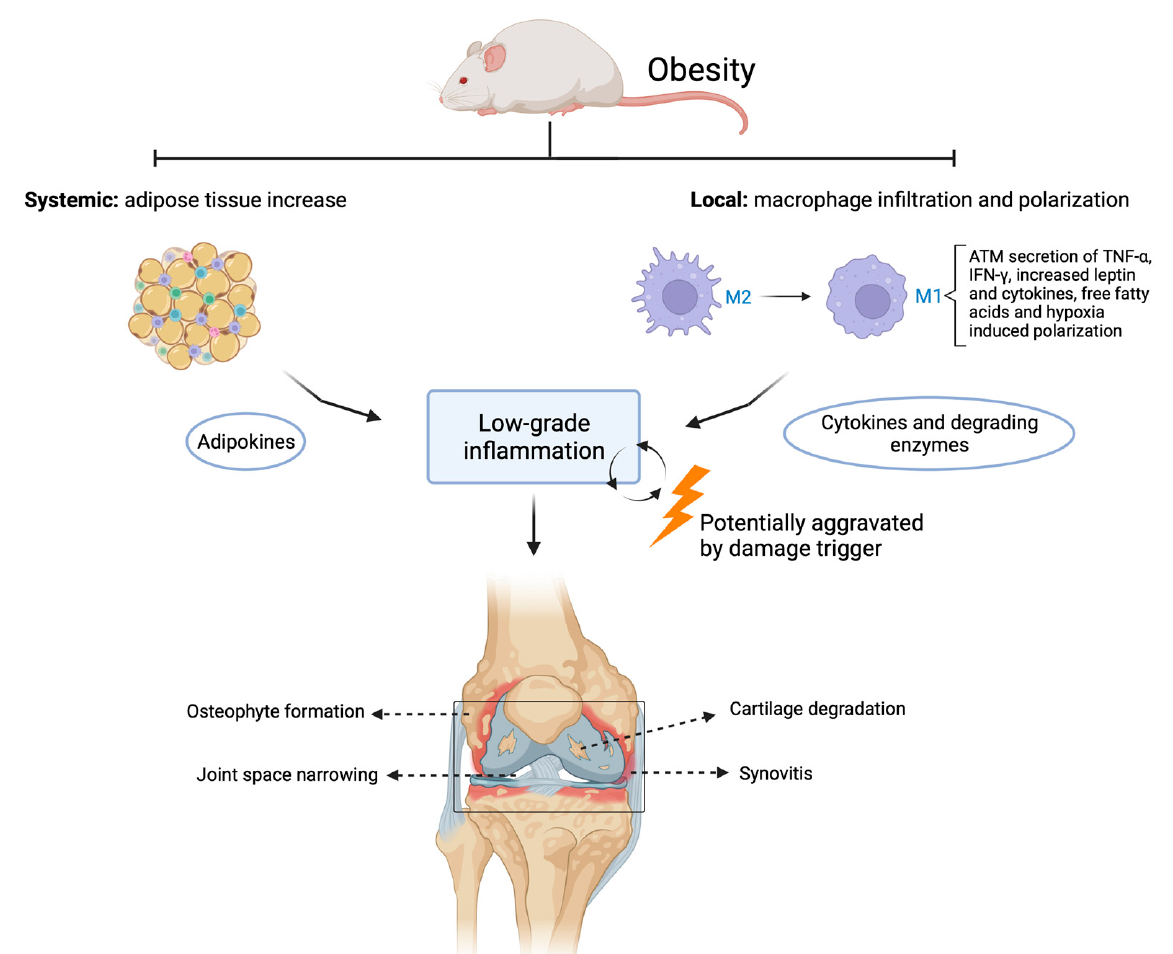
Figure 1. Contributing factors of obesity in metabolic OA. Systemically, adipocyte tissue increases, followed by a heightened adipokine release. In the joint, monocytes infiltrate, and a polarization switch occurs in macrophage phenotype from M2- to M1-like macrophages leading to increased release of pro-inflammatory cytokines and degrading enzymes. Both systemic and local factors contribute to a chronic state of low-grade inflammation that can lead to OA development, which is potentially further aggravated once damage occurs in the joint. ATM: adipose tissue macrophages .